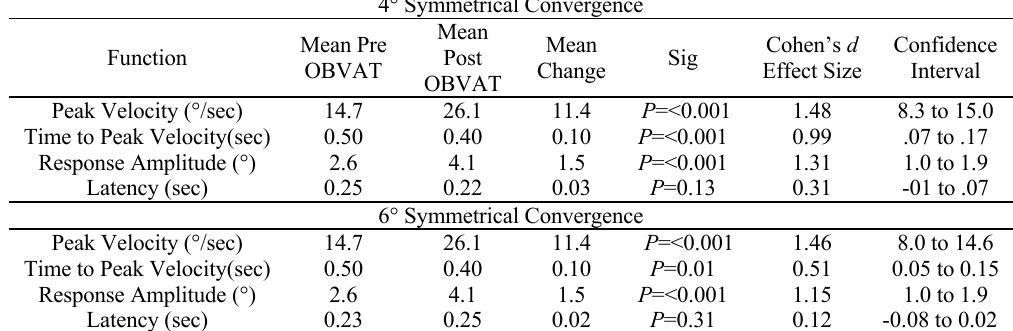
Table 2: Comparison of Objective Measures of Convergence Pre- and Post-OBVAT